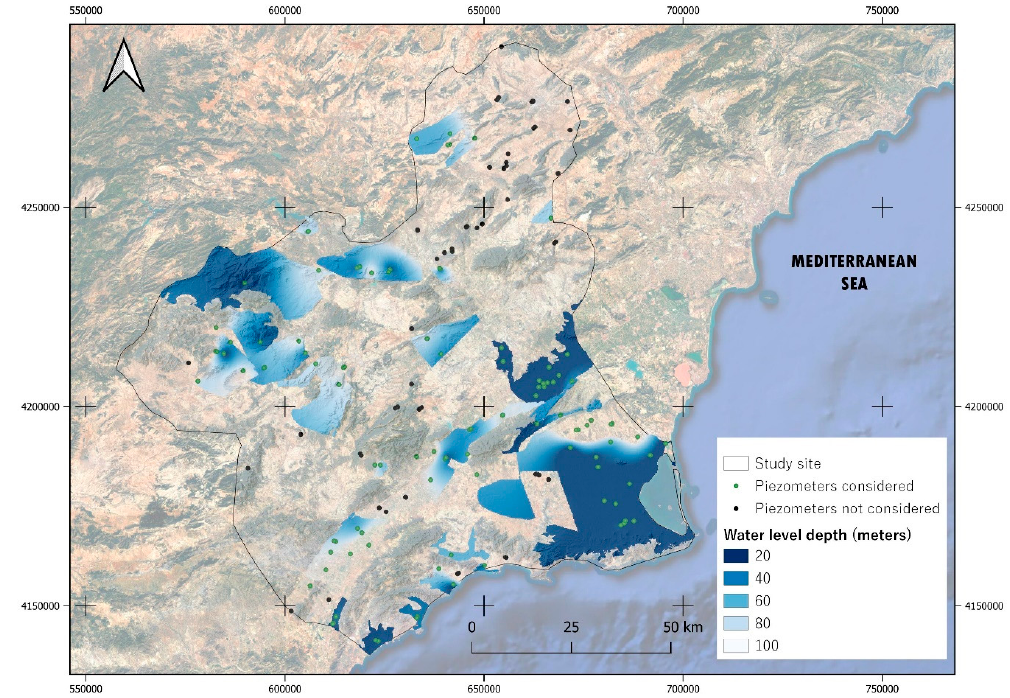
Figure 4. Map of the water table level from the surface to 100 m depth. The points represent the piezometers considered in the area. Green points represent those considered for the map and dark points represent those dismissed for the map, as the level goes deeper than 100 m.